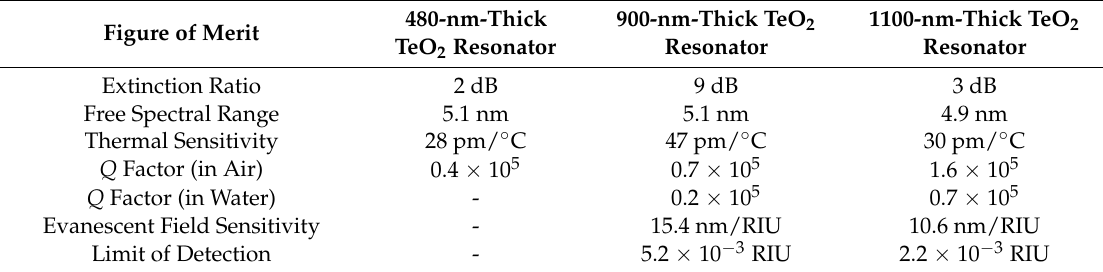
Table 1. Figures of merit for the tested 480-nm-, 900-nm- and 1100-nm-thick TeO 2 resonators. Figure of